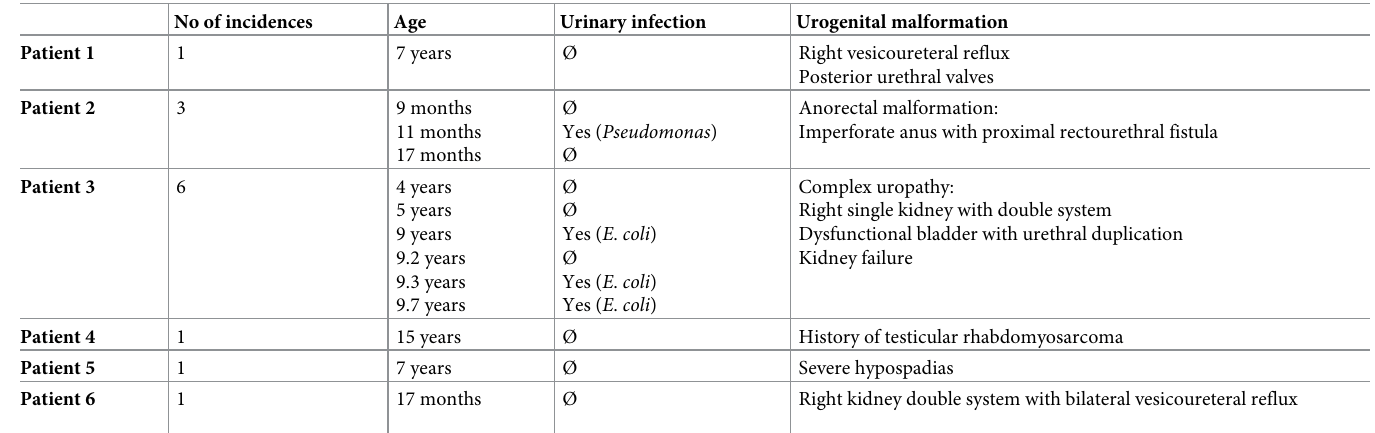
Table 4. Details of the 6 patients with a previously known urogenital